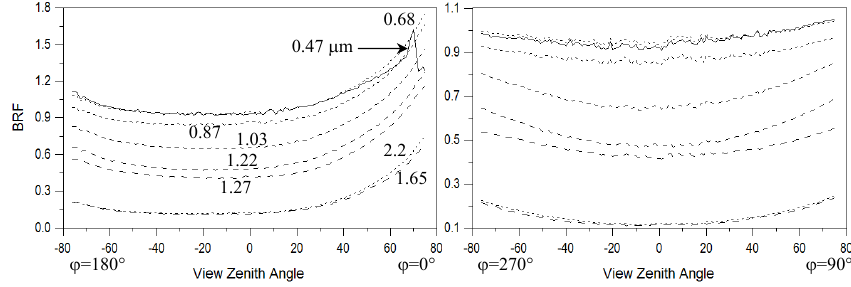
Fig. 4. Spectral snow BRF in eight CAR bands in the principle plane (left) and in the cross-plane (right) from flight 2001b (7 April 2008, altitude